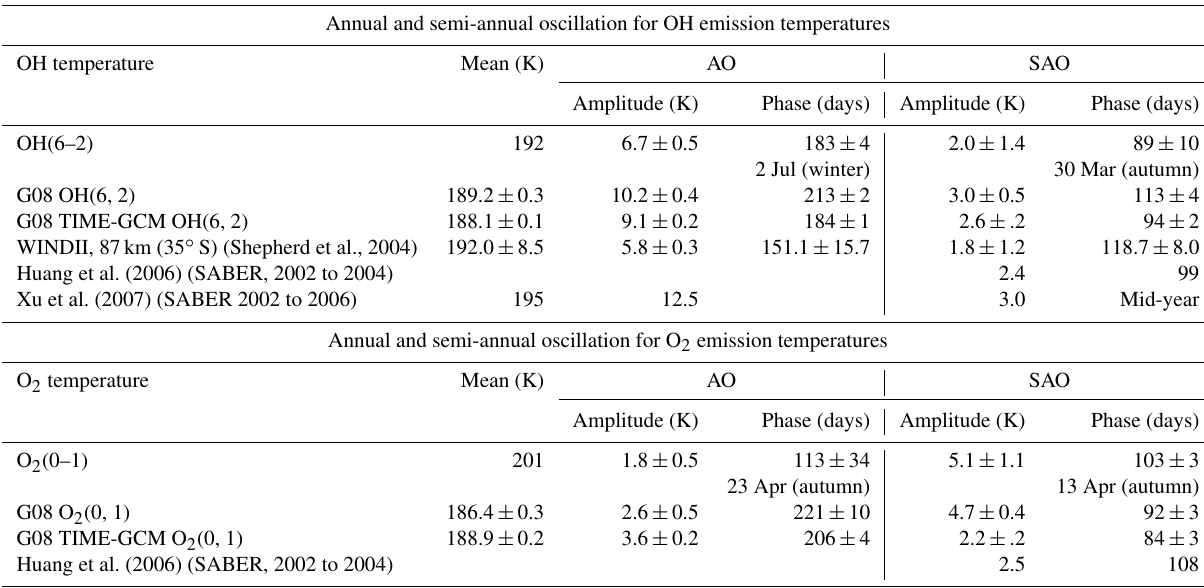
Table 3. OH and O 2 results from the current study compared with other observations and the TIME-GCM. The time interval for the current results was selected to match that for G08. See text for details.